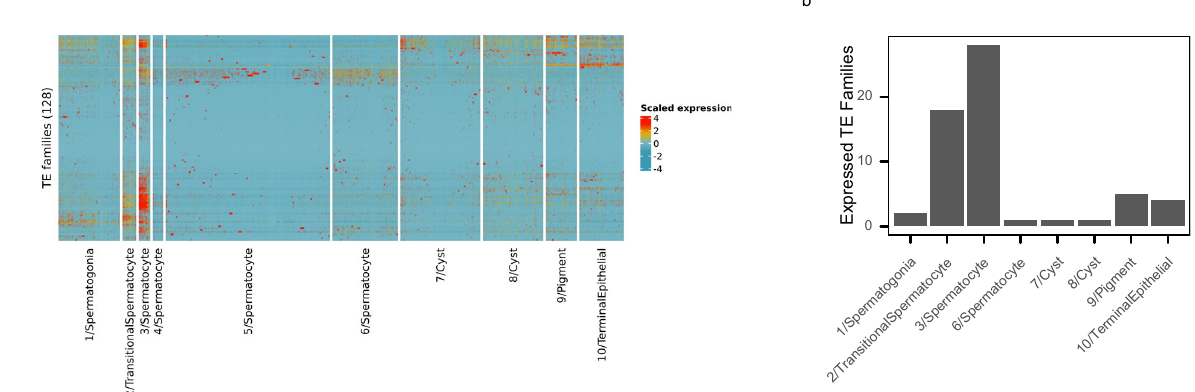
Fig. 2 A spermatocyte cluster expresses transposons at high levels. a Heatmap shows scaled expression levels of 128 transposable element (TE) families detected in this dataset across all cells. b The numbers of TE families with detectable expression in at least half of the cells in each cluster is shown. While most clusters express small groups of transposable elements or show sporadic expression of transposons in some member cells, cluster 3/Spermatocyte cells show high expression of many transposable elements. Cluster 2/Transitional Spermatocytes express the second highest number of TEs (18 families), 14 of which are shared with cluster 3. This pattern is consistent with a burst of TE expression that coincides with the developmental transition from spermatogonia to spermatocytes. Source data are provided as a Source Data